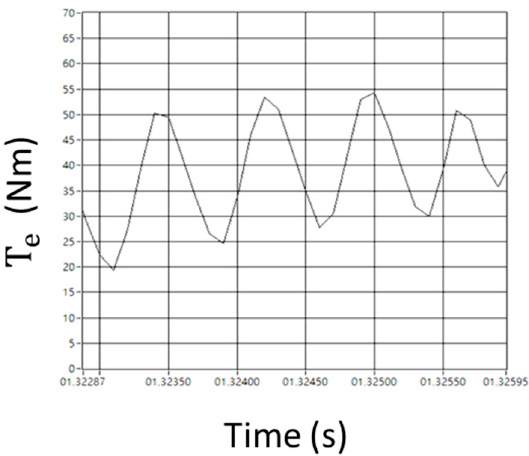
Figure 23. Electromagnetic torque of HIL test for cSVM-DTC1. Note that this figure was generated by the HIL directly, where on the horizontal axis, the number is from 1.32287 to 1.32595. This indicates that torque was recorded during the period between 1.32287 s and 1.32595 s.